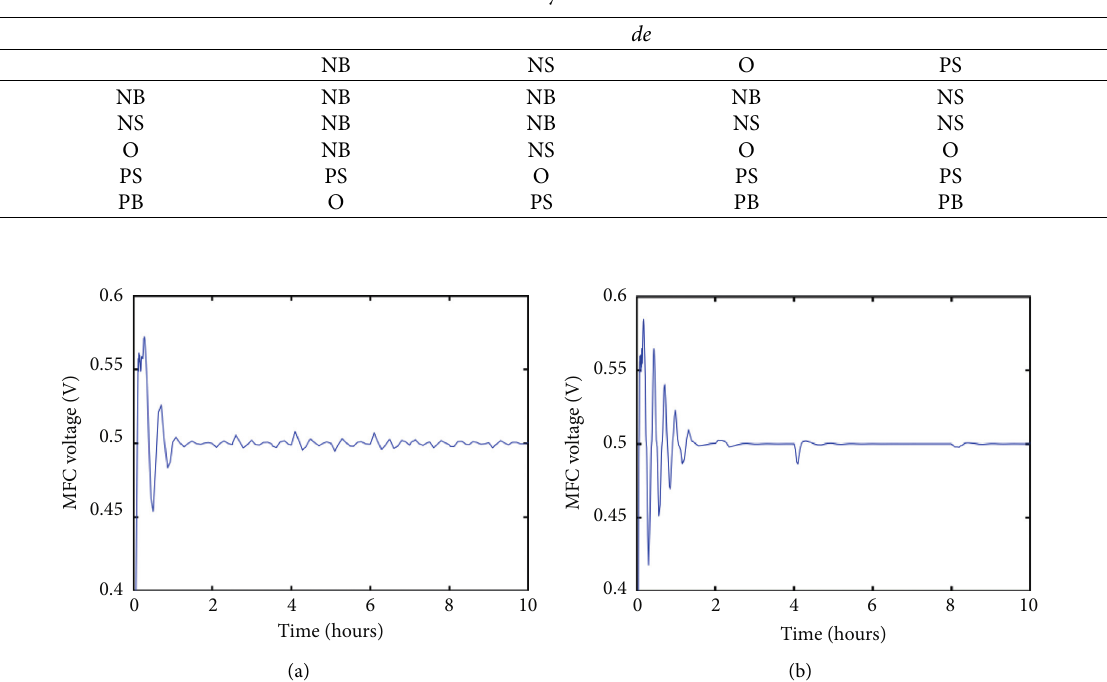
Figure 3: The control effect of (a) integral sliding mode control and (b) fuzzy integral sliding mode